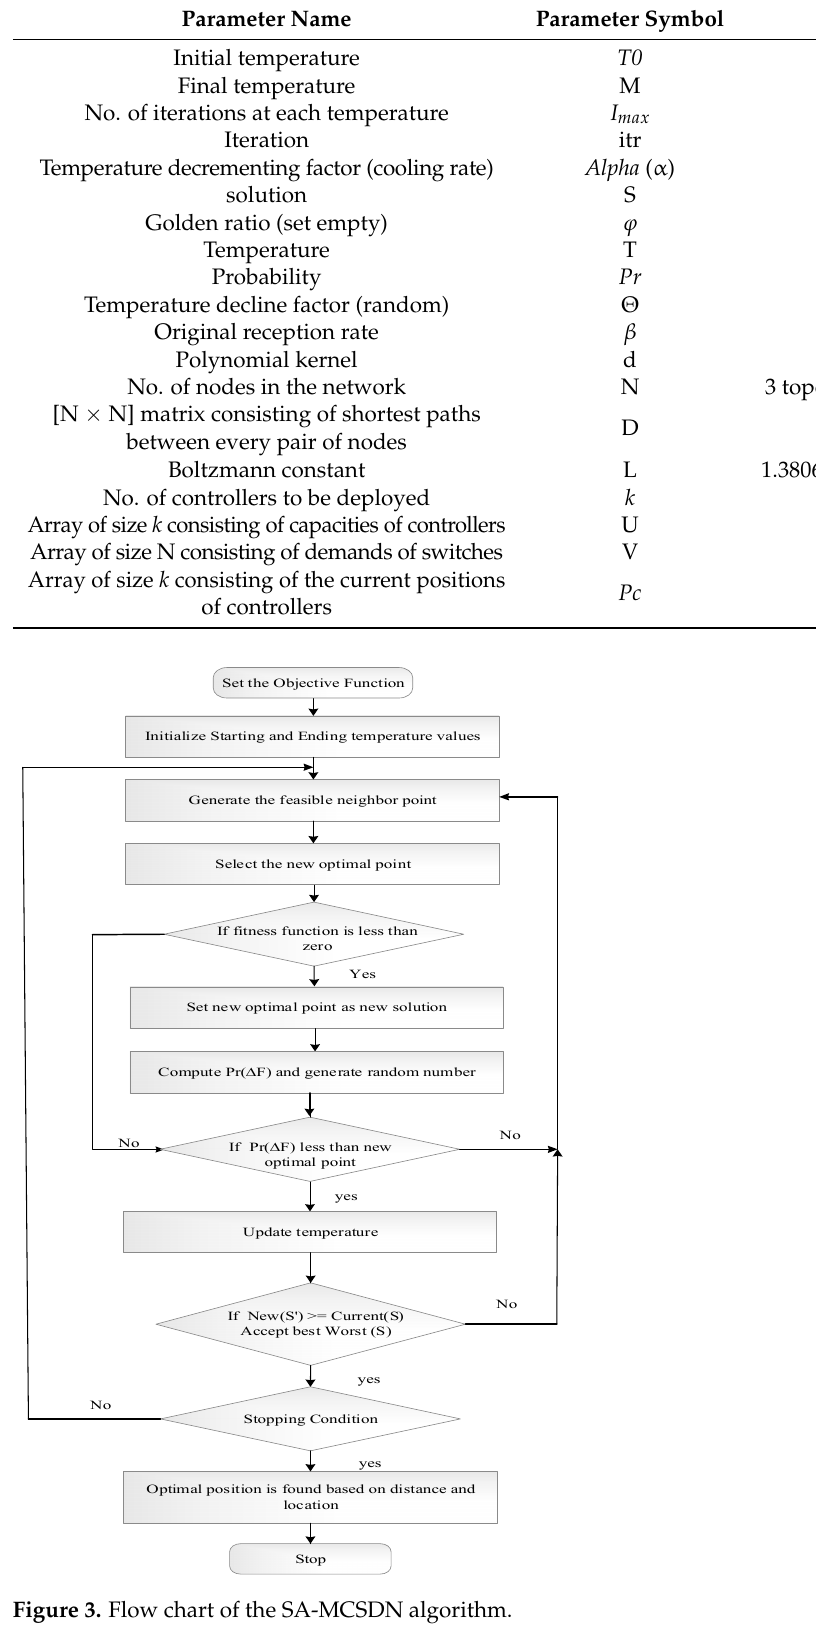
Table 4. Parameters and abbreviations of SA-MSDN algorithm optimization.